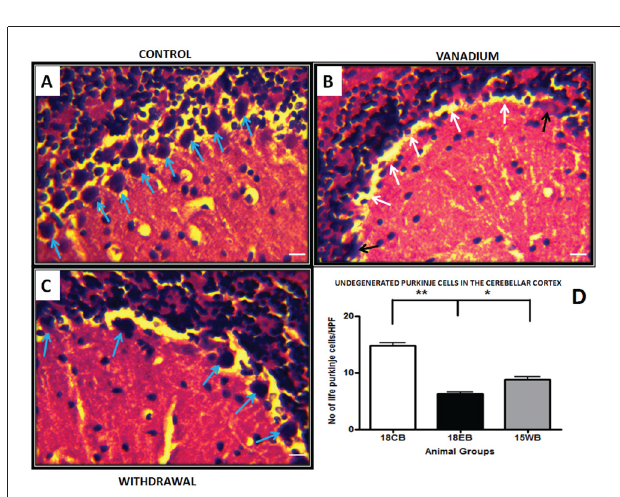
FIGURE 12 | Haematoxylin and Eosin (H&E) stained sections of cerebellar cortex for control mice (A) and vanadium 18 months exposed mice (B) and age matched withdrawal (C) . (A) Shows numerous Purkinje cells (blue arrows) intact in the Purkinje cell layer. The white arrows in (B) shows Purkinje cells detachment and sloughed cells (black arrows) from Purkinje cell layer, the withdrawal groups (C) shows less cell detachment compares with V groups. Quantitative analysis (D) revealed significantly ( ∗∗ P < 0.001) reduced Purkinje cell count in the vanadium exposed group relative to the control, while the withdrawal group count was significantly ( ∗ P < 0.05) high relative to vanadium group (D) , scale bar 25 µ